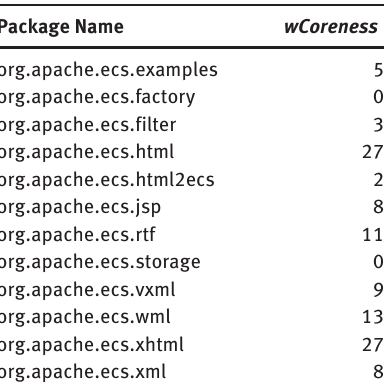
Table 7. wCoreness Values for Packages in Jakarta ECS.